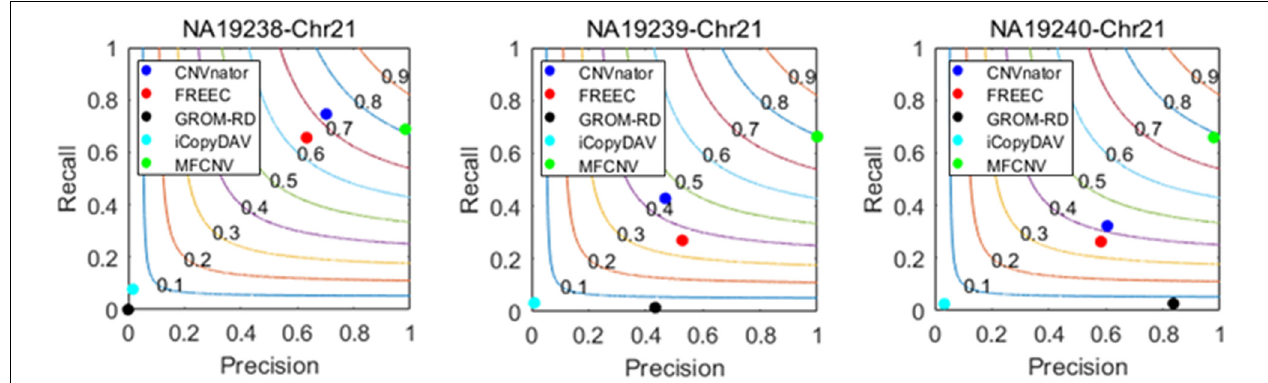
FIGURE 4 | Performance comparisons between our proposed method and the four peer methods in terms of recall, precision, and F1-score (colored curves) on real samples.